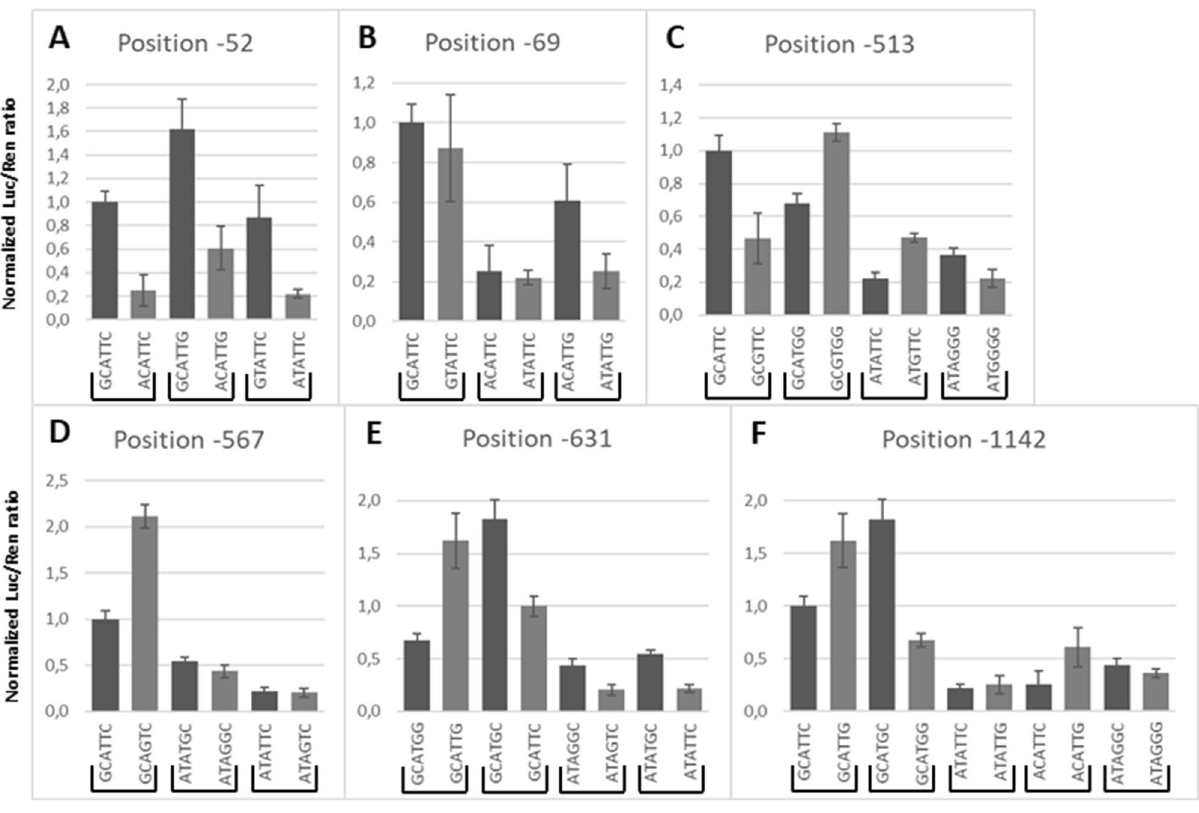
Figure 3. Luciferase reporter assay results grouped by position. The impact of SNPs was evaluated by pairwise comparison for each SNP site. Results of plasmid LRA were paired per site of change and identity of surrounding haplotype. The results demonstrate that surrounding haplotypes can have an impact on the functioning of the SNP, therefore, indicating an interaction between two sites (see sections "Results", "Reporter gene assay" and "Discussion").